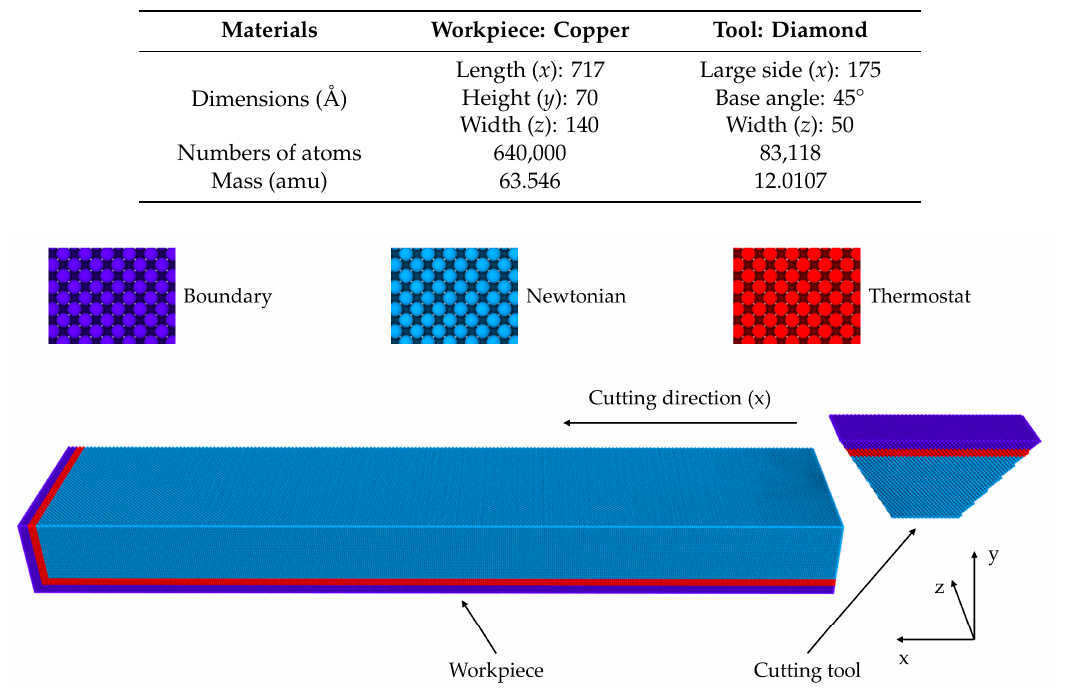
Figure 1. Molecular dynamics (MD) simulation domain.